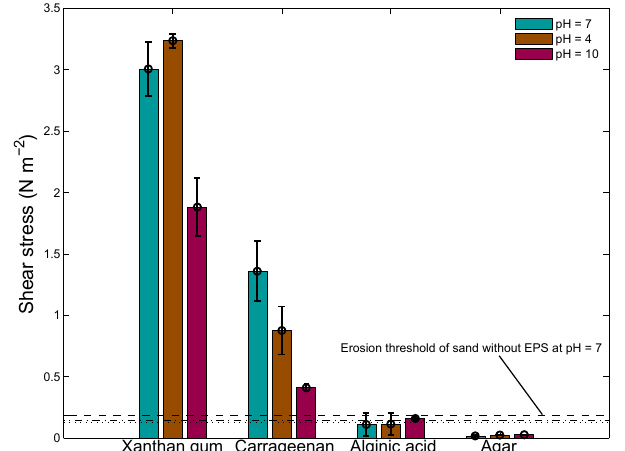
Figure 9. The threshold for erosion as a function of temperature for four extracted EPSs as measured with the CSM erosion device. The horizontal lines correspond to threshold for erosion of sand without EPSs for a temperature of 20 ◦ C (dashed), a temperature of 10 ◦ C (dotted) and a temperature of 40 ◦ C (dash dotted). Error bars are standard deviations from n = 3 repeat